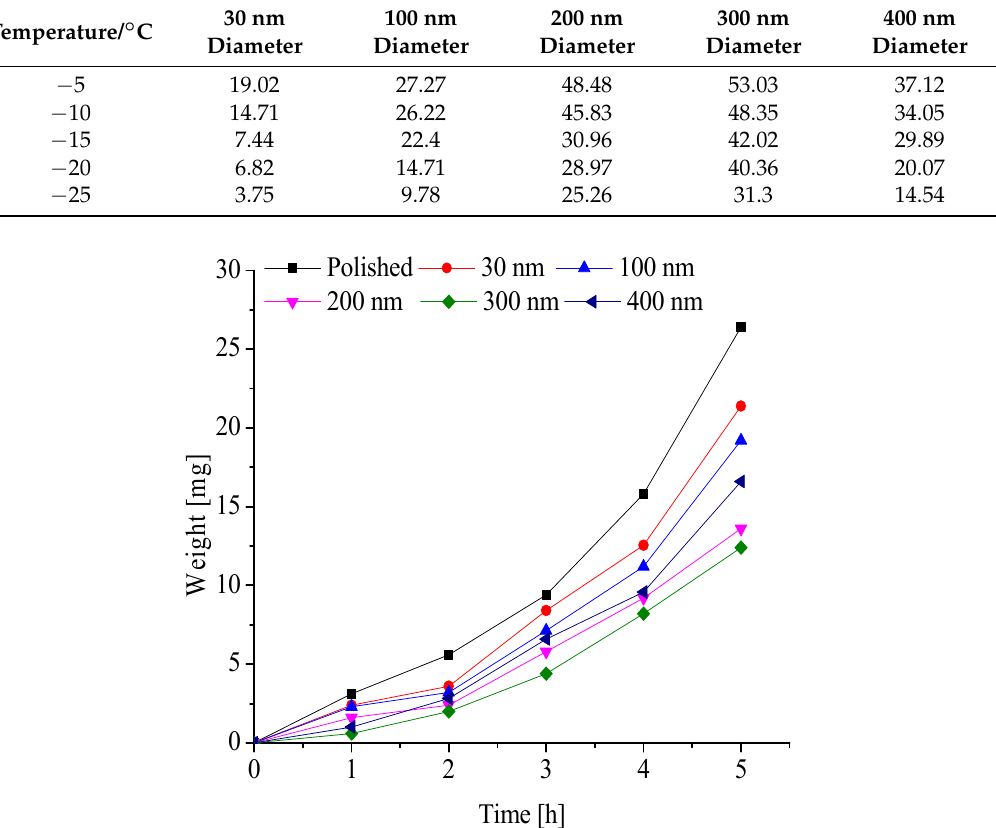
Figure 10. Variations of frost weight with different nanoporous diameters at T = − 5 °C, φ = 60%.